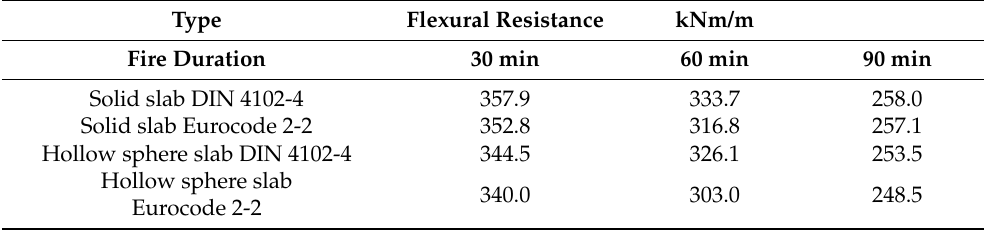
Table 3. Flexural resistances of the different slab types after 30, 60, and 90 min of fire exposure.